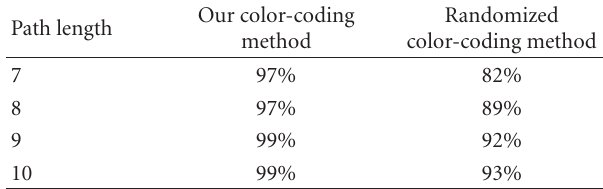
Table 1: The successful probability with varying lengths and fixed alpha = 0.5.